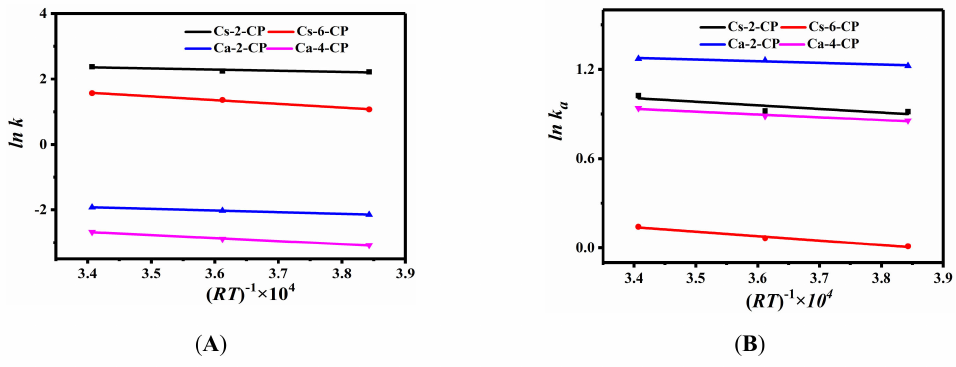
Figure 3. Relationships between ln k and ( RT ) − 1 × 10 4 ( A ), as well as ln k a and ( RT ) − 1 × 10 4 ( B